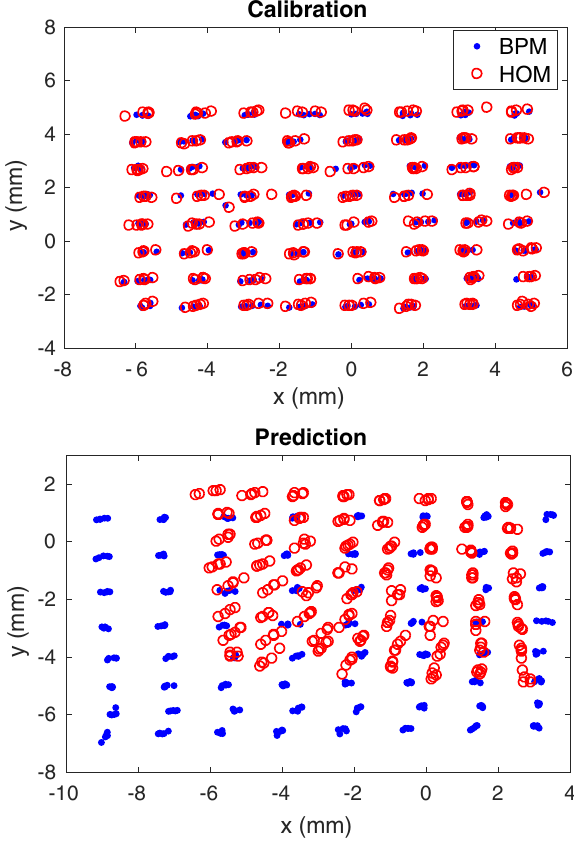
FIG. 10. HOMBPM calibration in April (top) and prediction in May (bottom) based on SVD method from cavity four (HOM1). The blue points are the beam positions interpolated from the BPMs and the red circles are the beam positions calculated based on HOM signals with the SVD method. The RMS error between the blue and red positions is 0.13 mm in x and 0.09 mm in y for the calibration data, 1.17 mm in x and 1.48 mm in y for the prediction.